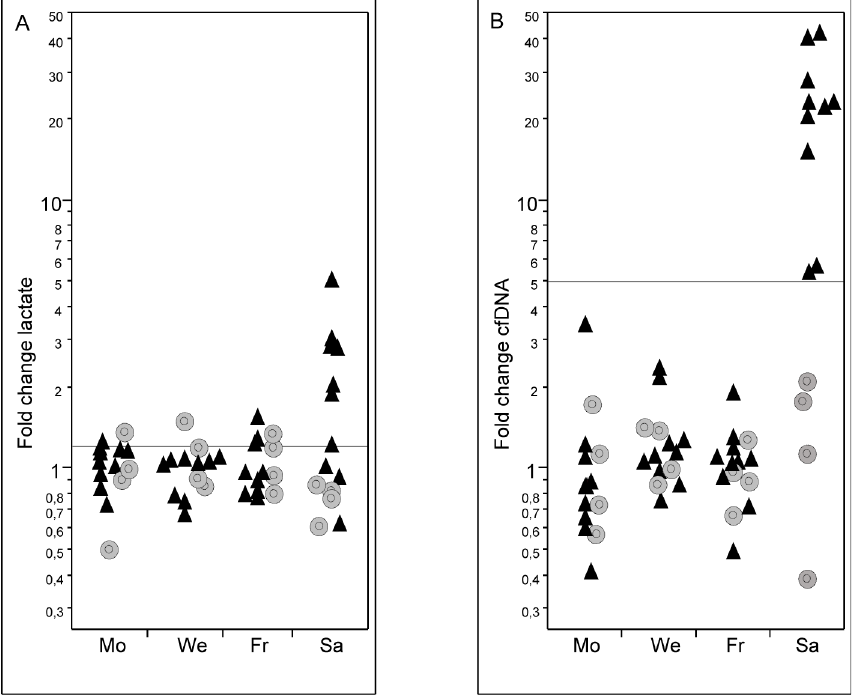
Fig 3. Fold-changes of cfDNA and lactate and after the football game. Fold-changes of lactate (A) and cfDNA (B) of a regular training week at rest (Mo, We, Fr) and post-game values after the match (Sa). Fold-changes were determined using the geometric mean of all three baseline values as 1-fold. Players who played more than 70 minutes on Saturday are in black triangles; bench players in grey circles.